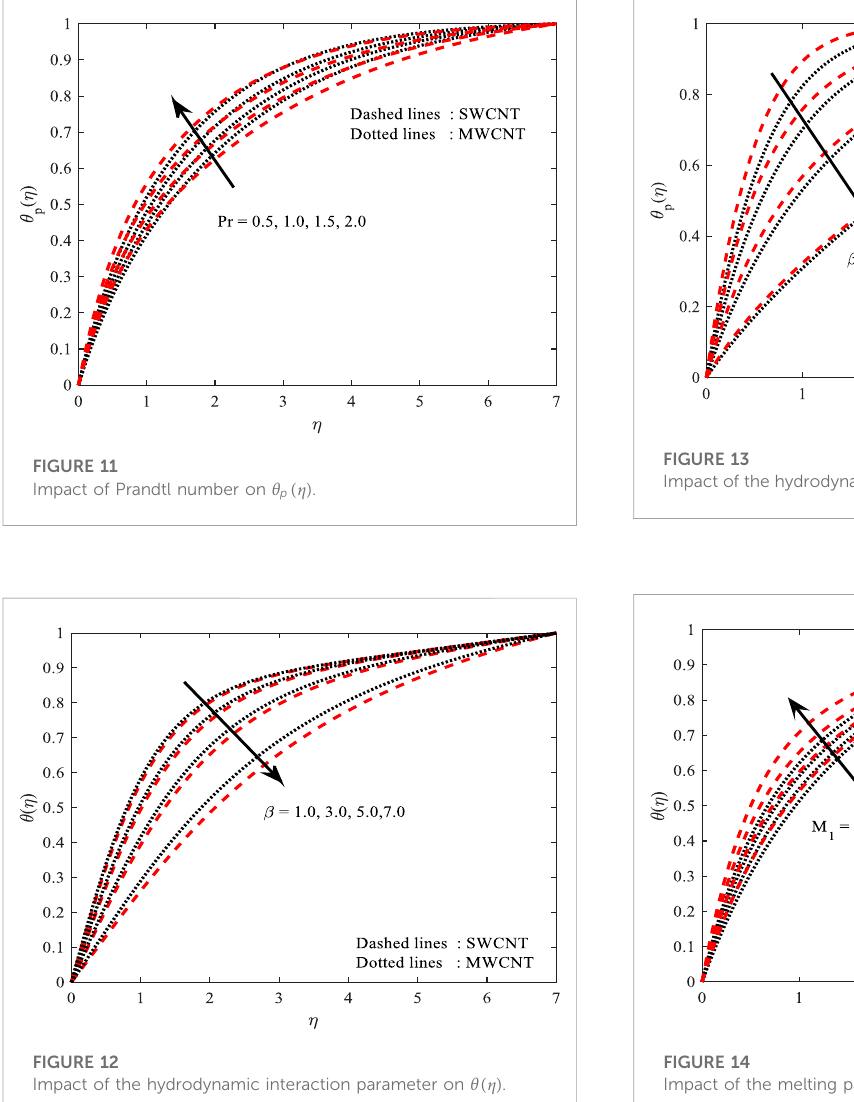
FIGURE 14 Impact of the melting parameter on θ ( η )